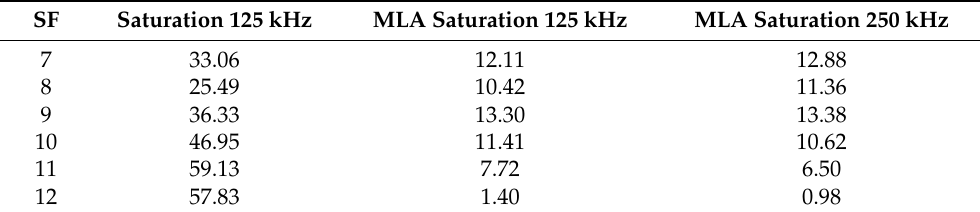
Table 8. Saturation comparison.